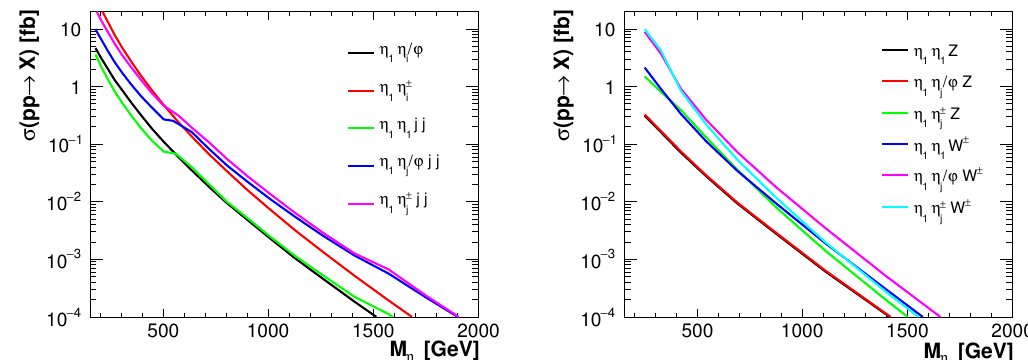
Figure 4 . Production cross section of (cid:17) 1 at the LHC with centre of mass energy of 14 TeV as a function of the mass for di(cid:11)erent channels. We applied a general cut on the transverse momentum of jets of p jet > 20 GeV. T